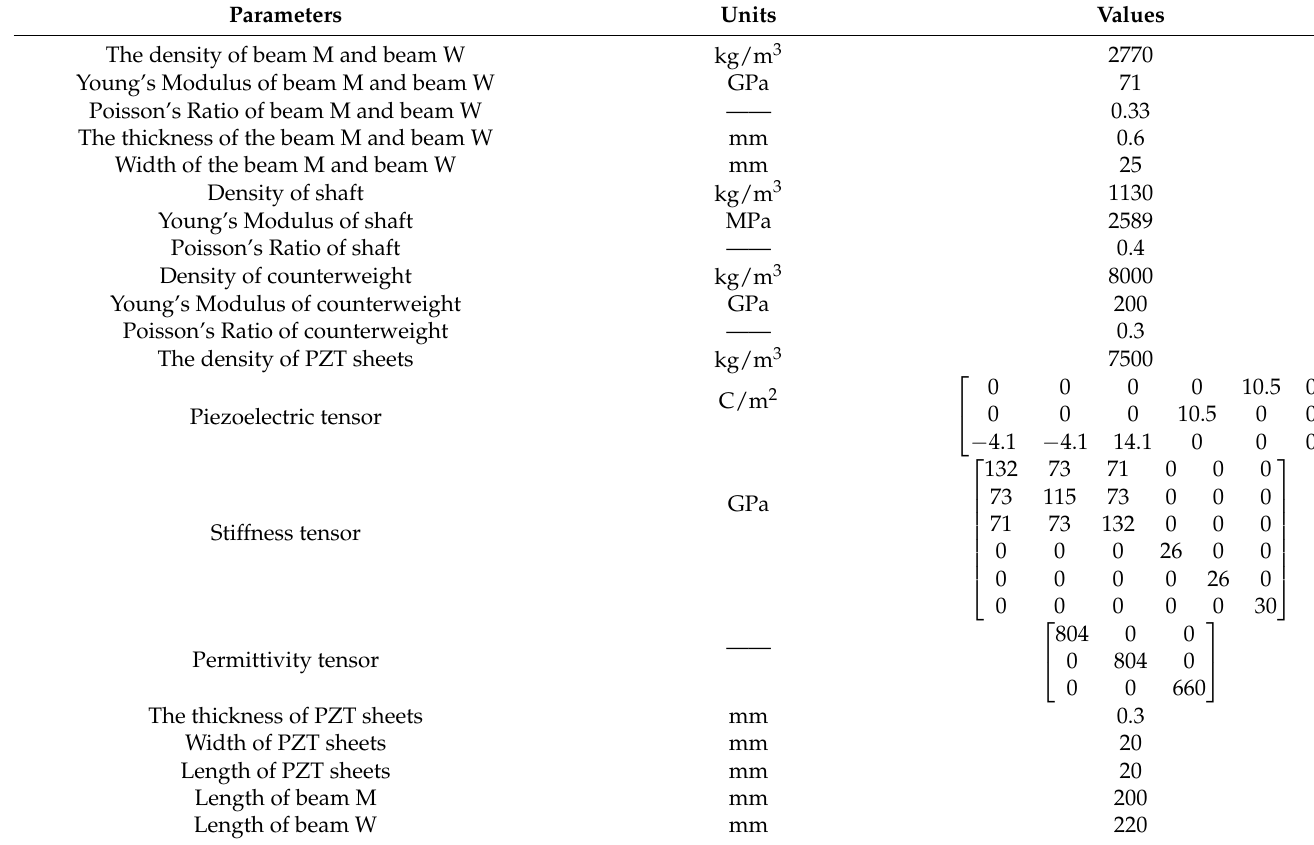
Table 1. Material and structural parameters of the energy